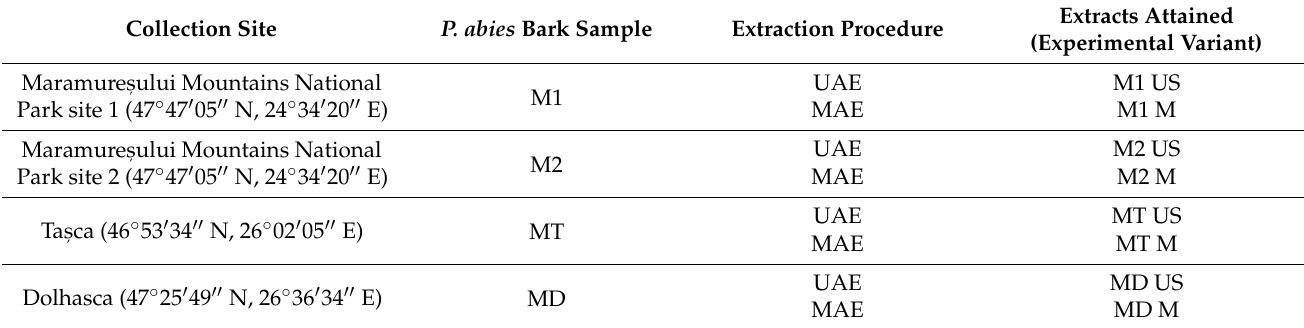
Table 5. Experimental variants for each collection site and extraction method